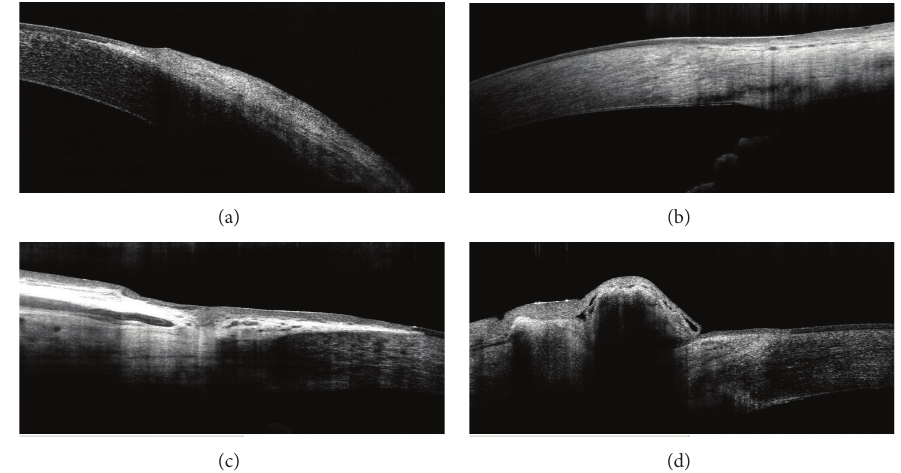
Figure 3: AS-OCT images of pterygium and pinguecula. Pterygium with corneal opacity (a), pterygium without corneal opacity (b), pseu- dopterygium (c), and pinguecula (d).